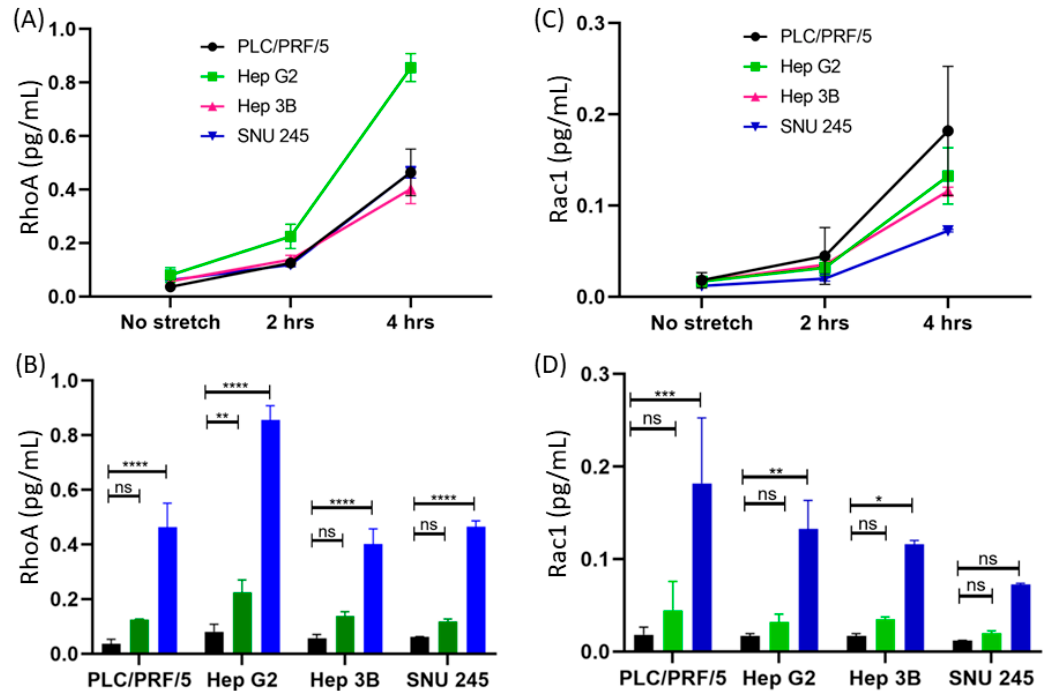
Figure 3. Time course of expression of RhoA and Rac1 before and after applying the strain in various types of liver cancer cells. We measured the released biomarkers after multiple durations of mechanical stretching, i.e., 0 (control), 2 and 4 h. To quantify the levels of expression of RhoA and Rac1 in response to cyclic strain, the ELISA detection method was used. ( A ) Quantitative measurement of RhoA activity in multiple cell lines pre and post stretching for 2 and 4 h; ( B ) quantification of RhoA before and after the stretching for 2 and 4 h of PLC / PRF / 5, HepG2, Hep3B and SNU-245 liver cancer samples; ( C ) measurement of Rac1 quantity in multiple cell lines pre and post stretching for 2 and 4 h; ( D ) quantification of Rac1 pre and post the stretching for 2 and 4 h of PLC / PRF / 5, HepG2, Hep3B and SNU-245 liver cancer samples. The p values were obtained using Student’s t -test. (*): p ≤ 0.05; (**): p ≤ 0.005, (***): p ≤ 0.0005 and (****): p ≤ 0.0001. The error bars show the standard deviations of